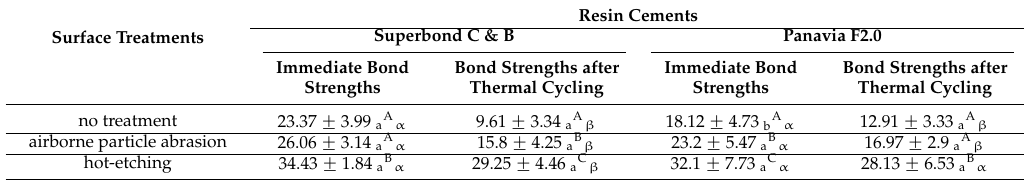
The shear bond strength (MPa) of zirconia with different surface treatments (Mean ˘ standard